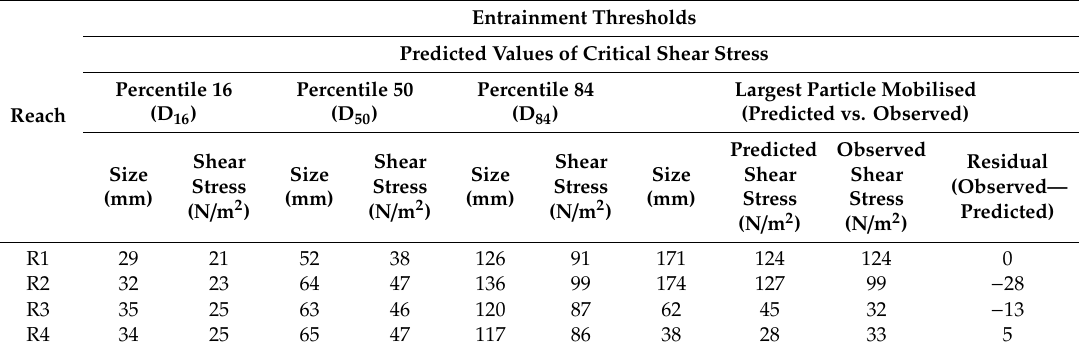
Table 4. Entrainment thresholds in the study reaches of the Noguera Pallaresa: Predicted shear stress values for representative percentiles of the coarse surface layer and for the largest particles